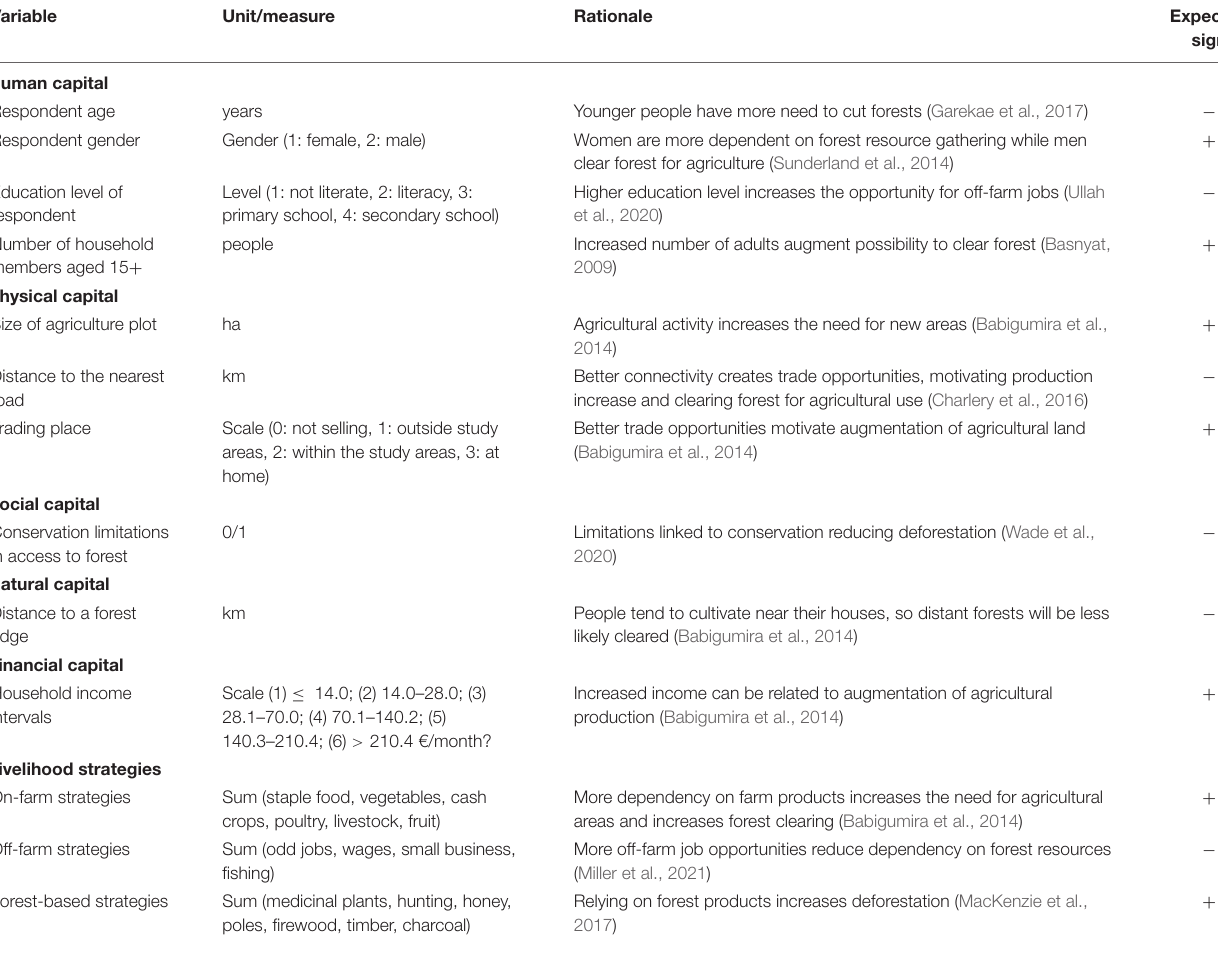
TABLE 1 | Summary of variables used in the logit model to predict household forest clearing decisions at MFR and SCH.